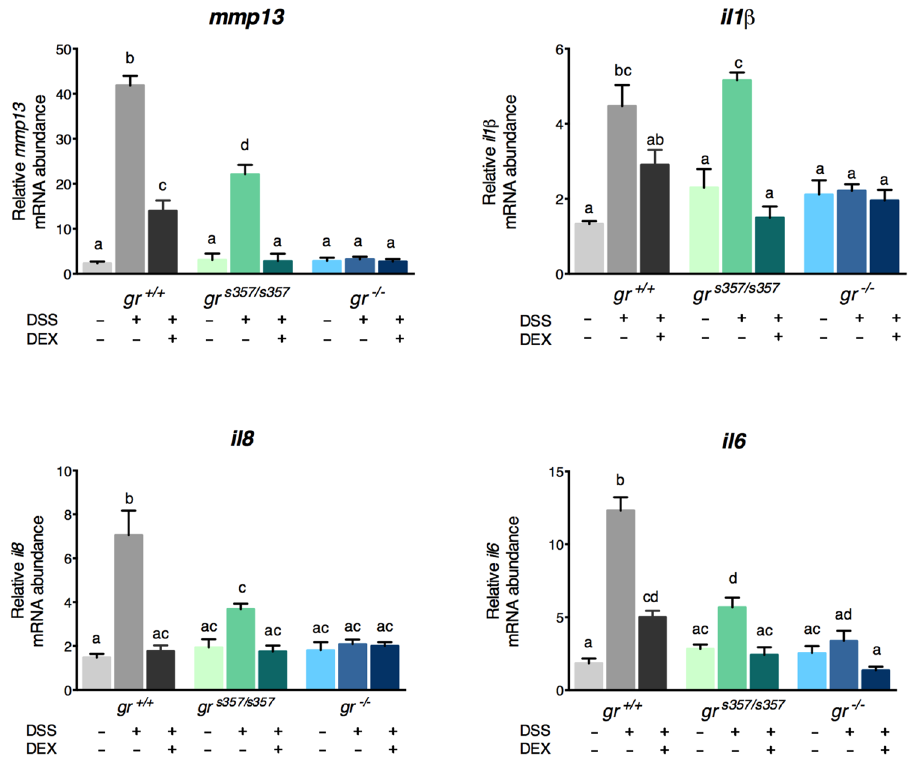
Figure 6. The gr − / − mutant line does not respond to an inflammatory stimulus. qRT-PCR analysis of mmp - 13 , il1 β , il8 and il6 in gr + / + , gr s357 / s357 and gr − / − 5-dpf zebrafish larvae deriving from homozygous parents under basal conditions and after a 20-h DSS treatment followed or not by 24-h DEX treatment. Values represent the mean ± SEM. Different letters indicate statistically significant differences checked by two-way ANOVA followed by Tukey’s multiple-comparison test. mmp13 (P < 0.001), il1 β (P < 0.01); il8 and il6 ( P < 0.001). Data were generated from four biological